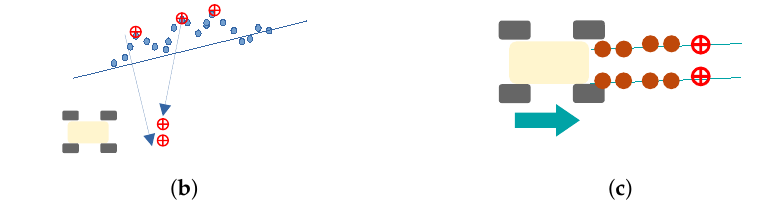
Figure 5. Steps of the furrow detection algorithm. ( a ) Measurement; ( b ) correlation; ( c ) updated